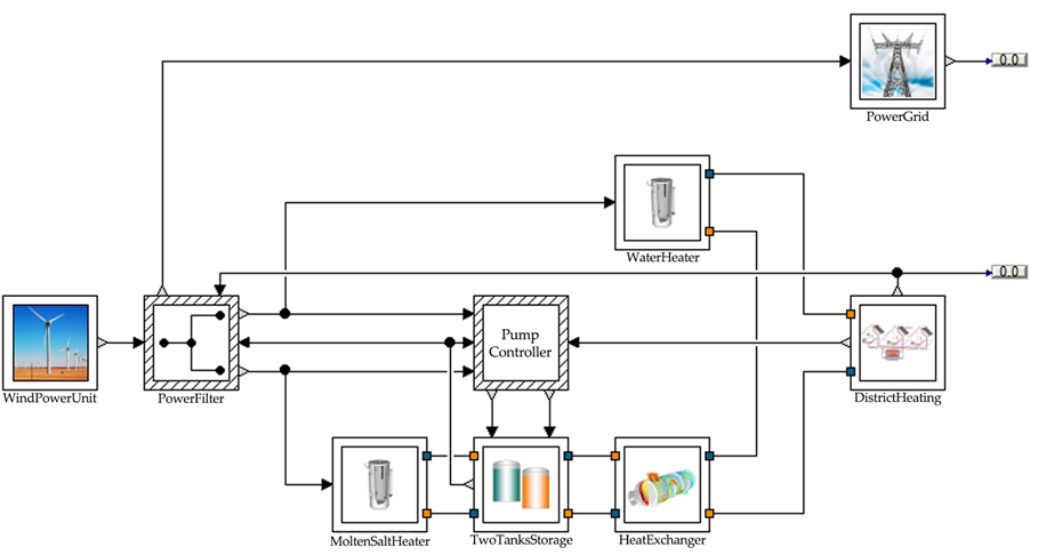
Figure 4. Structure of the proposed WTES system model.